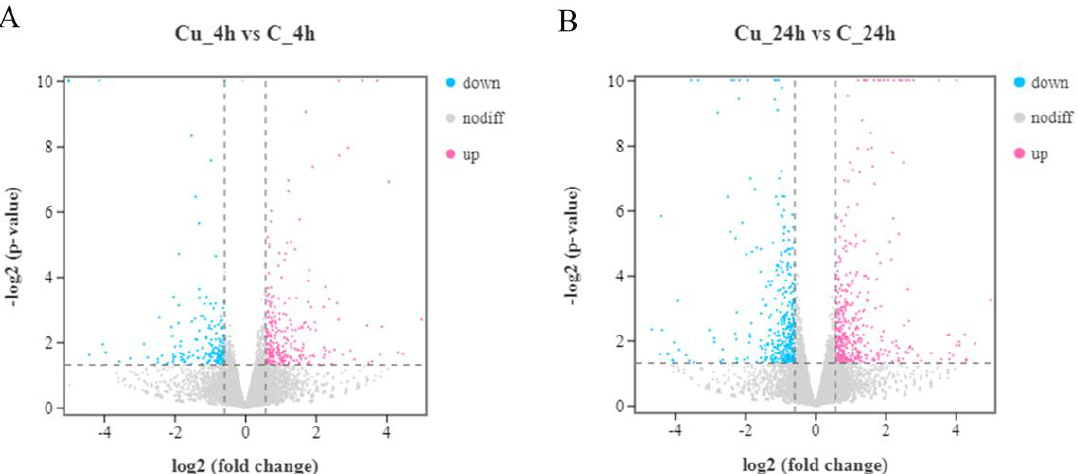
Figure 1. Expression difference of DEGs. ( A ) DEGs expression distribution at 4 h exposure. ( B ) ex- pression distribution of DEGs at 24 h exposure.